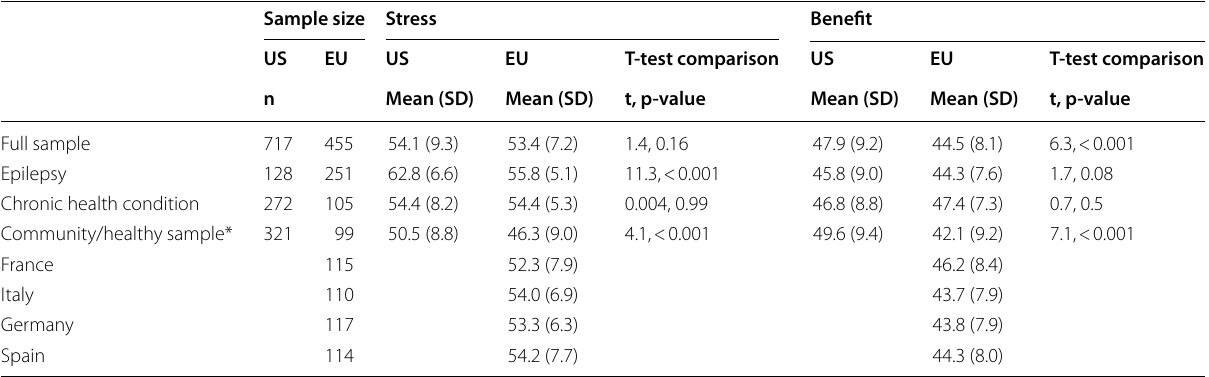
Table 3 Caregiver stress and benefit scores and comparisons across subgroups and countries in the European Union and the United States